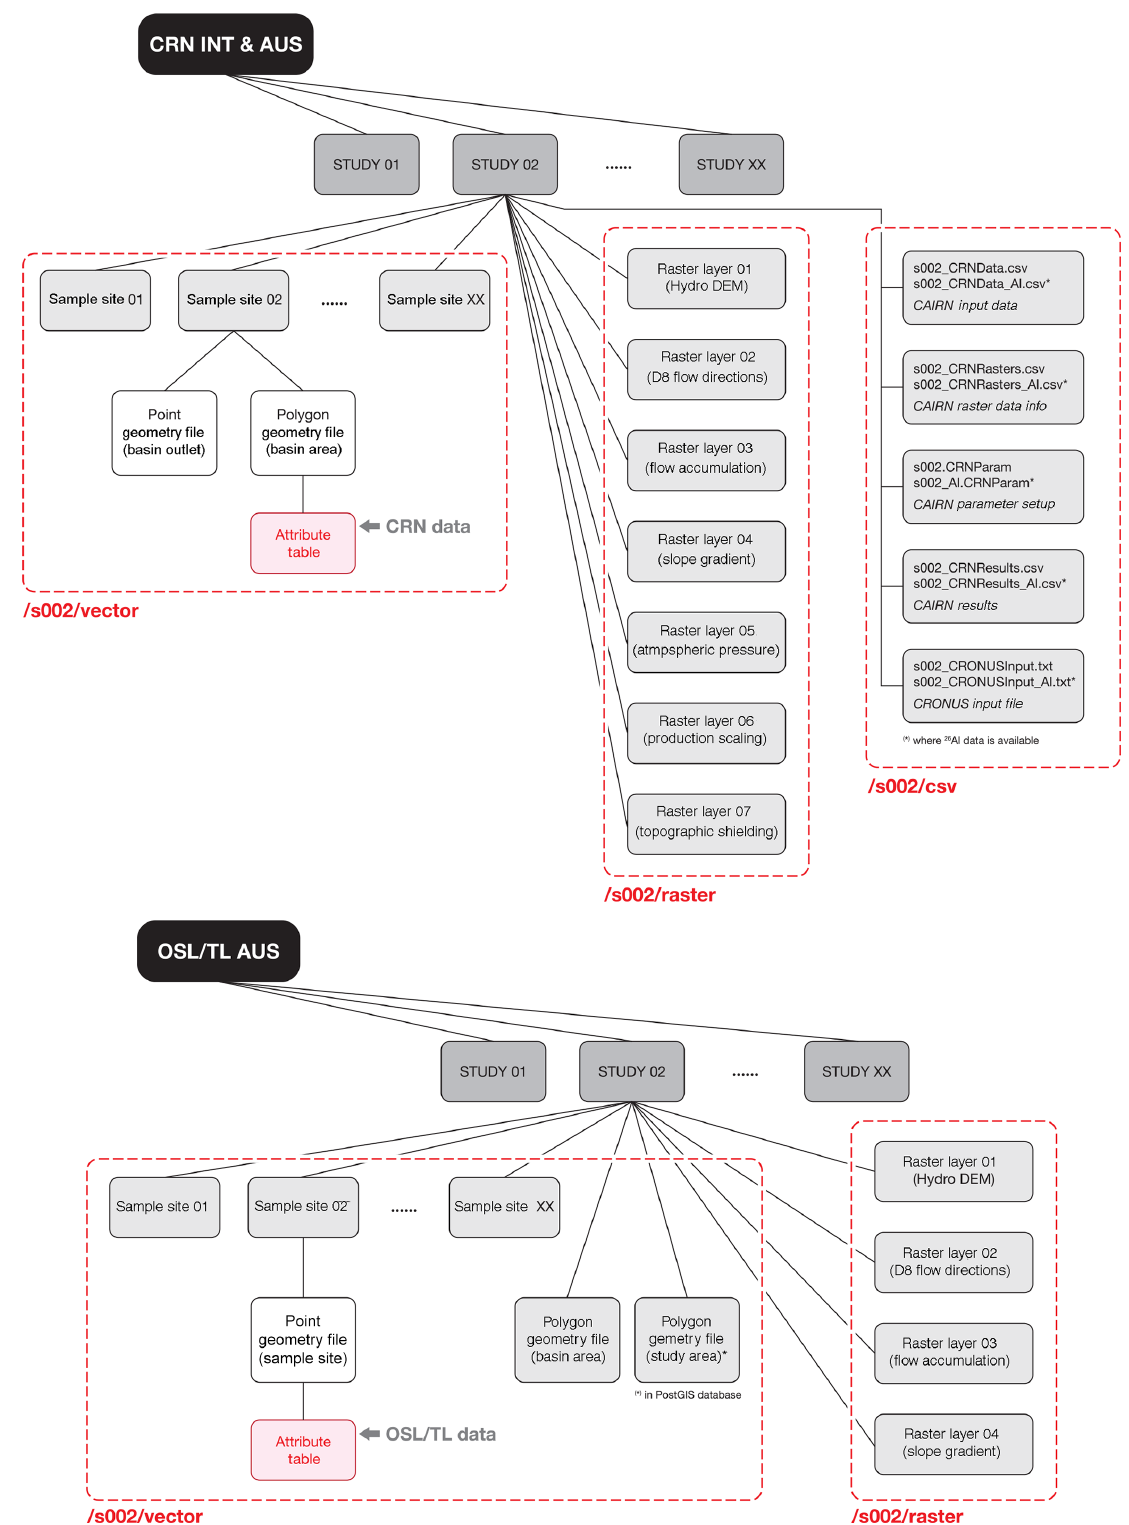
Figure 5. Data organisation diagrams for the CRN and OSL–TL collections. See text for details.